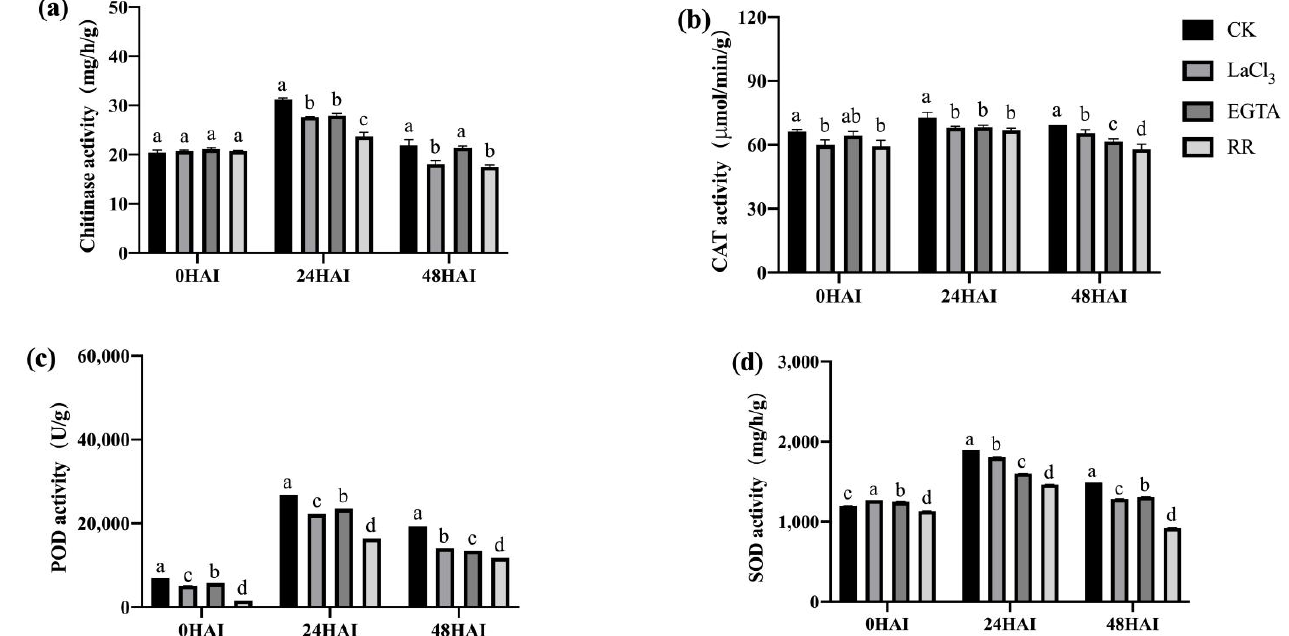
Figure 12. Ca 2+ chelating agent/channel inhibitor treatments inhibited the activities of chitinase ( a ), CAT ( b ), POD ( c ), and SOD ( d ) in low-vigor maize seeds under F. graminearum infection. EGTA, ethylene glycol-bis(beta-aminoethyl ether)-N-tetraacetic acid; RR, Ruthenium Red; CK, control; HAI, hours after inoculation. Different letters indicate significant differences among different lines (Tukey’s test).